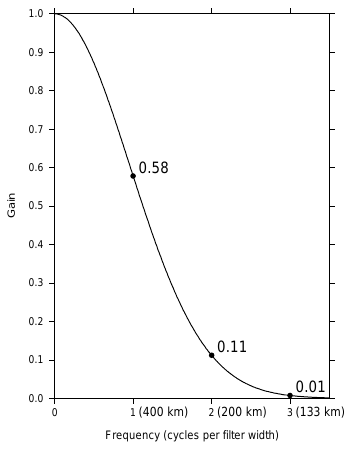
Figure 1. TransferfunctionoftheGaussianlowpassfilter. Thesignal attenuation is a function of the frequency and the wave- length, which is given for a filter width of b = 400 km in parentheses. The main benefit of GOCE is approximately in a band between wavelengths of 400 and 200 km (repre- senting a spatial resolution of 200 to 100 km).